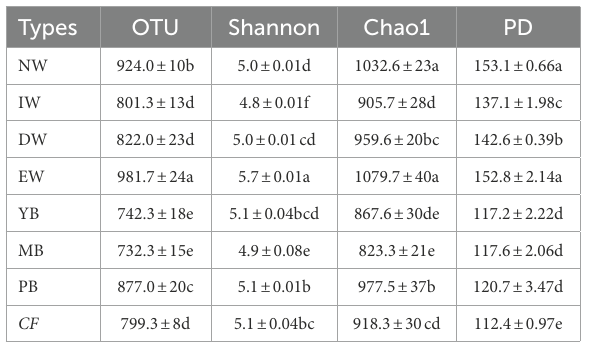
TABLE 2 Soil Acidobacterial α -diversity along a degraded wetland in Sanjiang plain.